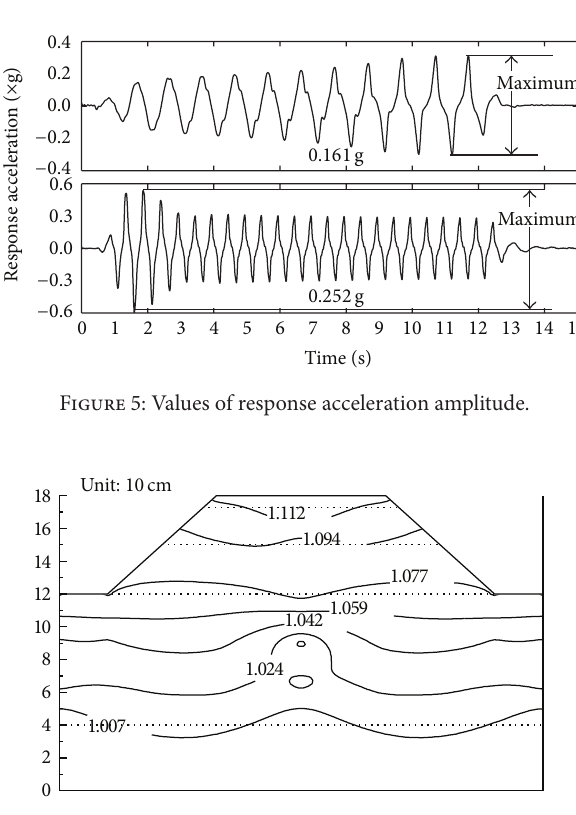
Figure 8: At 0.161 g loading